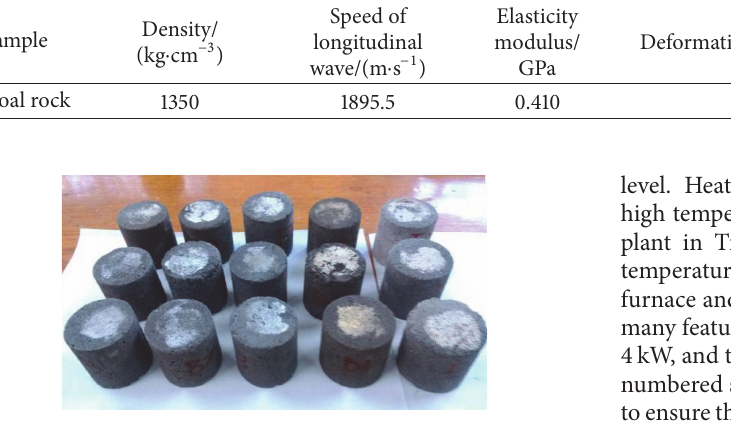
Figure 1: Physical maps of coal rock